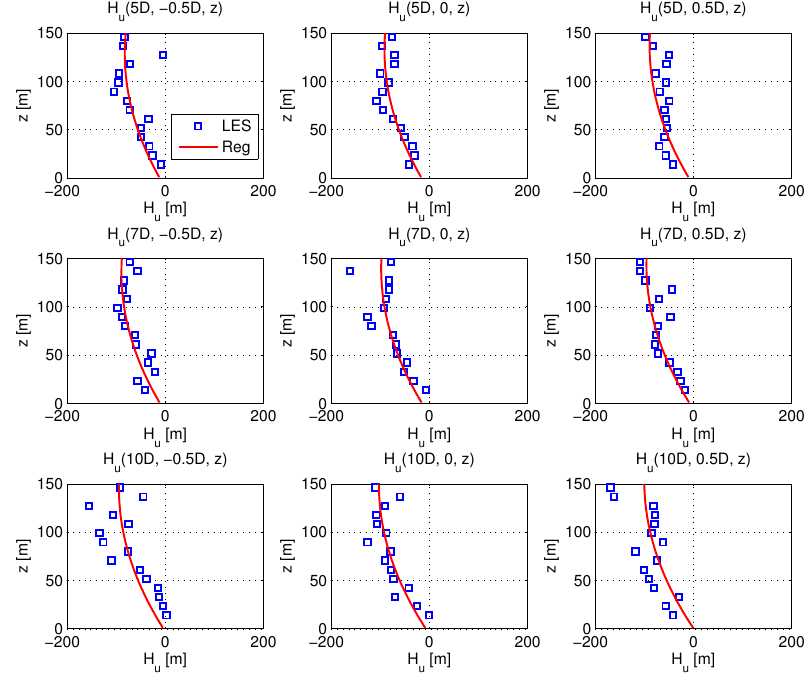
Figure 24. Spatial variation of H u : LES versus regression-based